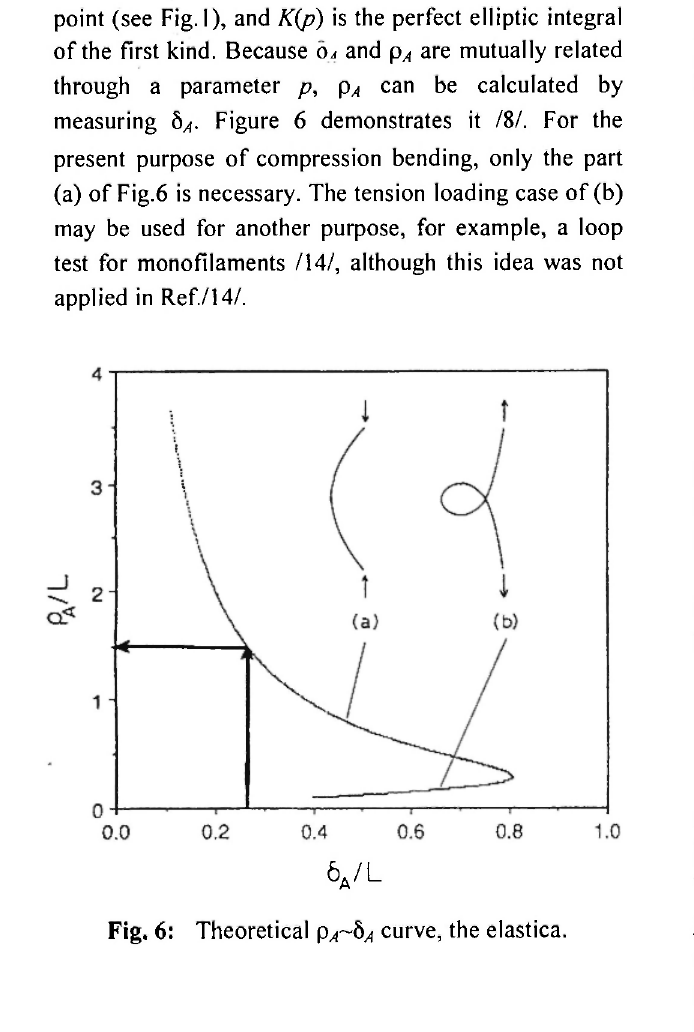
Fig. 7: Comparison of bending